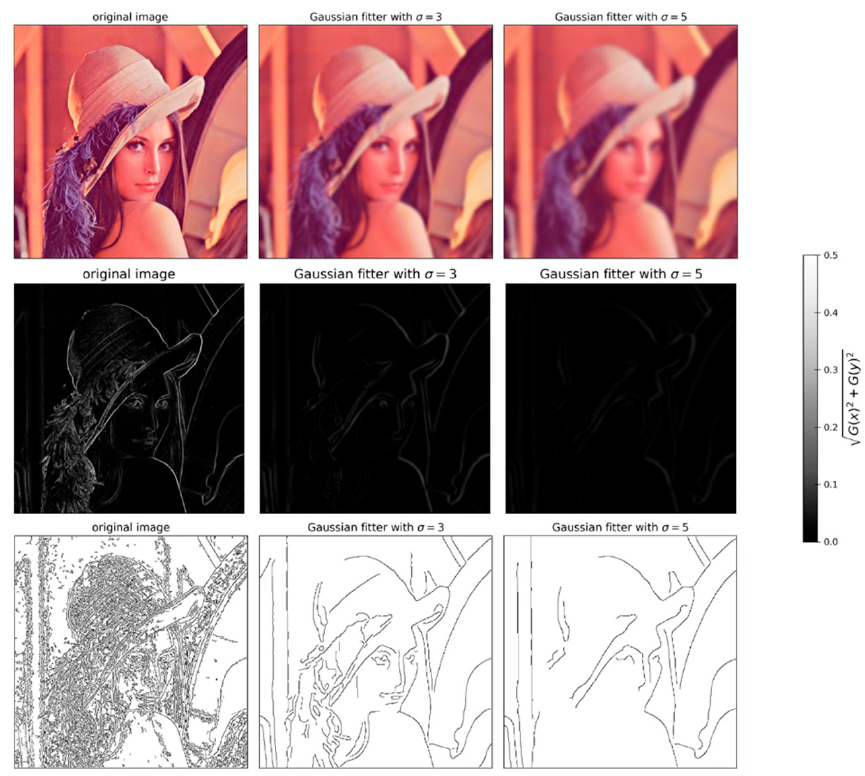
Figure 3. Steps of Canny edge detection simulations with different sigma values.